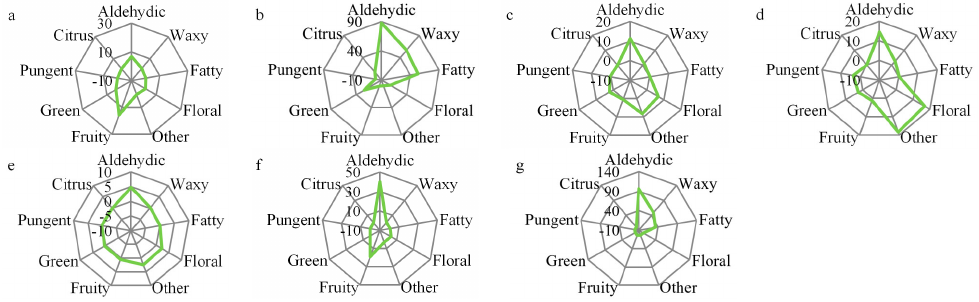
Figure 4. Radar map of aroma series based on the accumulated OAVs. ( a ) Anli, ( b ) Bayuesu, ( c ) Brown peel, ( d ) Golden, ( e ) KorlaXiangli, ( f ) Lyubaoshi, and ( g ) Xizilü.